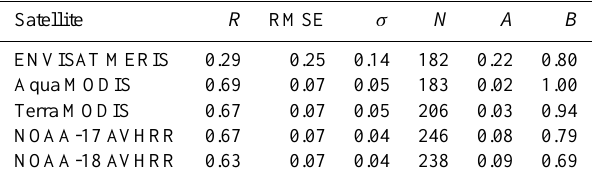
Table 4. Comparison of monthly average τ a between AERONET and the various satellites. The parameters are the same as in Table